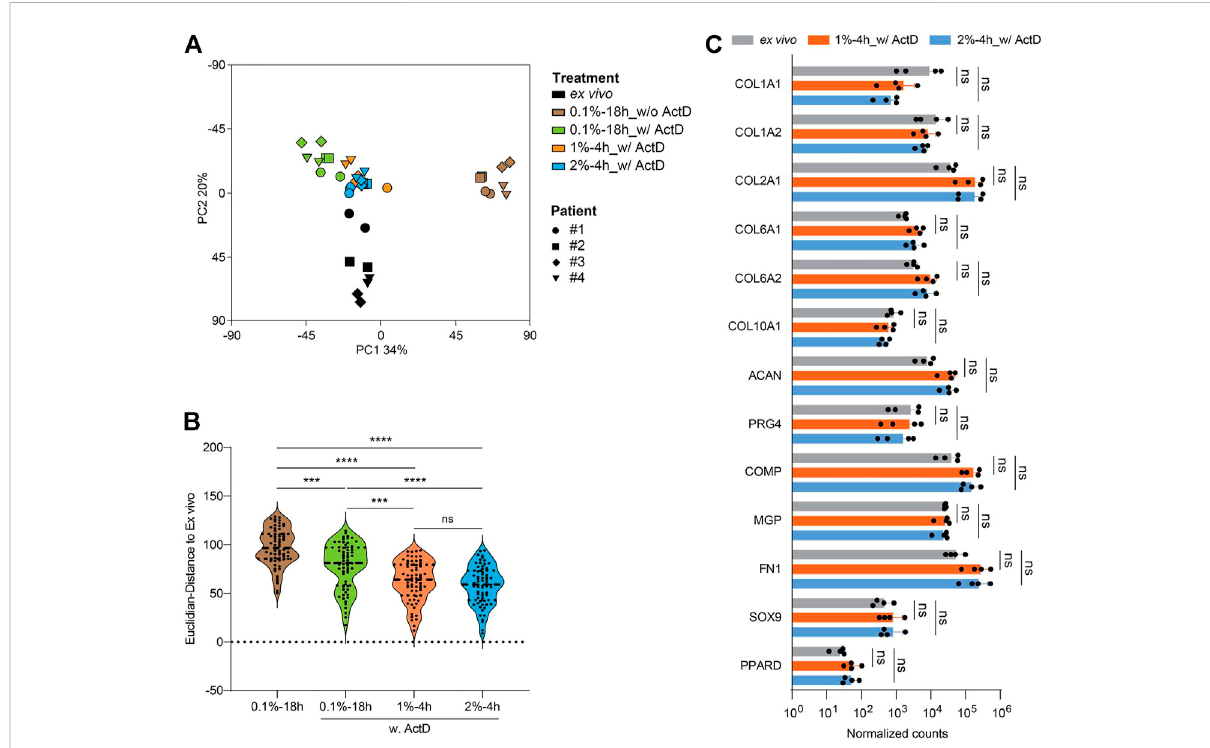
FIGURE 7 Cartilage digestion with 1% or 2% collagenase II for 4 h plus ActD yields a chondrocyte population with highest transcriptome preservation. RNA-seq analysis was done for chondrocytes harvested after 4-h digestion with 1% or 2% collagenase II, and 18-h digestion with 0.1% collagenase II withorwithoutActD.Inaddition,RNAisolateddirectlyexvivofromcartilagetissueofthesamepatientswassequenced(eachsampletworeplicates). (A) PCA plot shows the clustering of each group of samples. (B) The Euclidian distance between the transcriptomes of each group of isolated cells and RNA from total cartilage tissue ex vivo is plotted. (C) The expression of 13 hallmark genes of chondrocytes including COL1A1, COL1A2, COL2A1,COL6A1,COL6A2,COL10A1,ACAN,PRG4,COMP,MGP,FN1,SOX9,andPPARDfromfourpatientsisplotted.DatainBandCwereanalyzed using paired One-way ANOVA (ns: p > 0.05, *** p < 0.001, **** p <